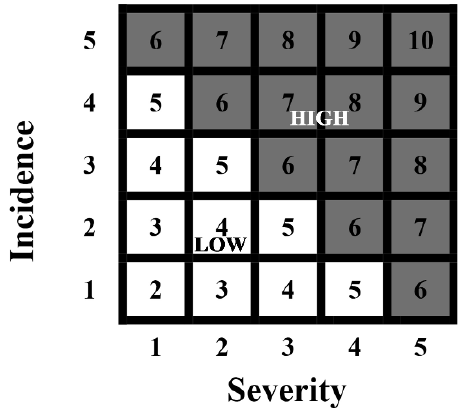
Figure 4. Risk matrix of farmer response scoring.